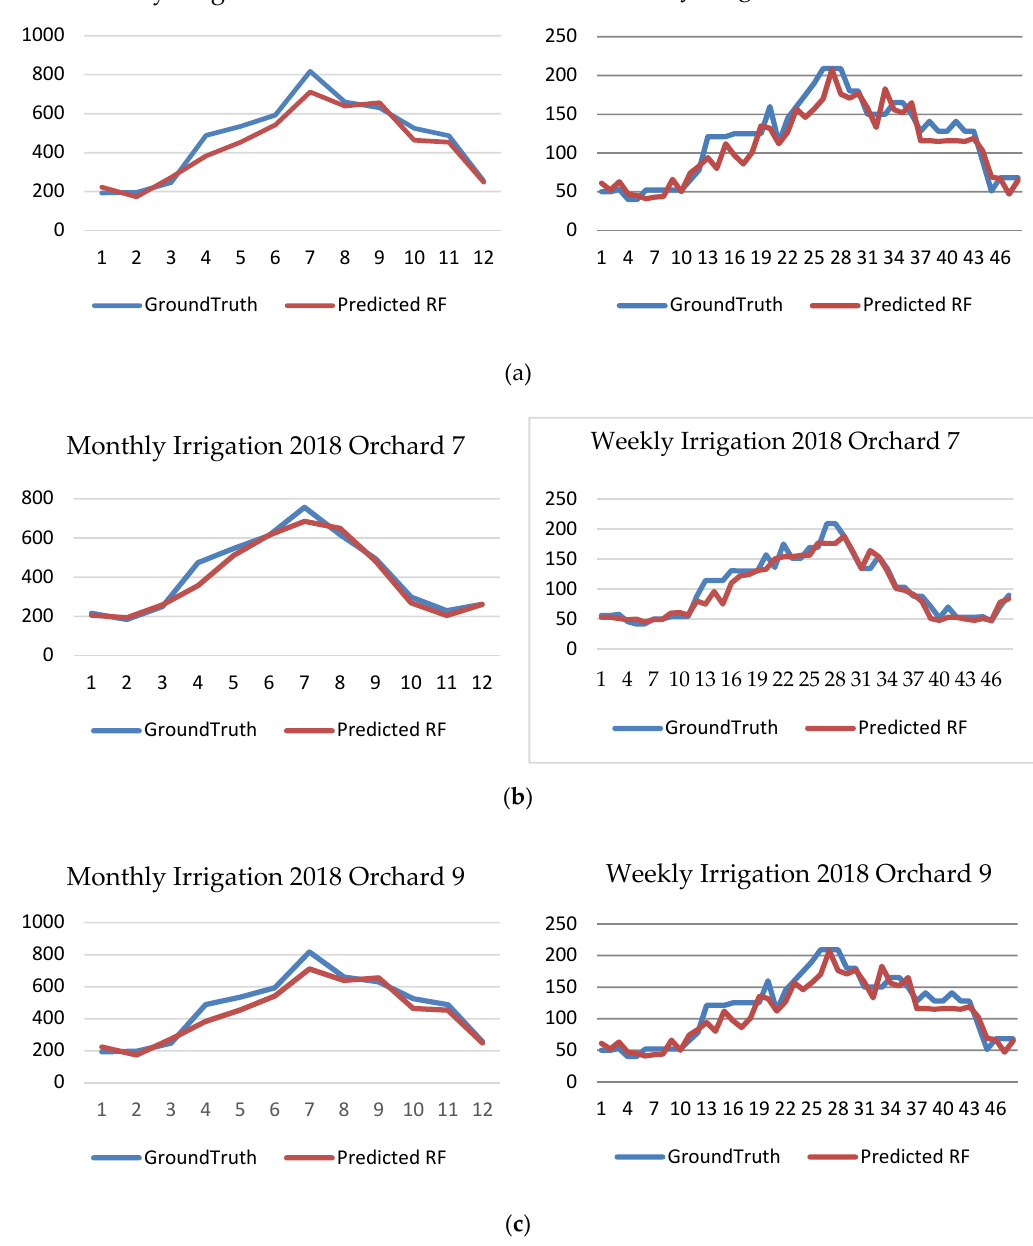
Figure 8. Comparison between the irrigation applied by the expert (ground-truth) and the one predicted by the RFR model for the year 2018: ( a ) Orchard 1; ( b ) Orchard 2; ( c ) Orchard 3.